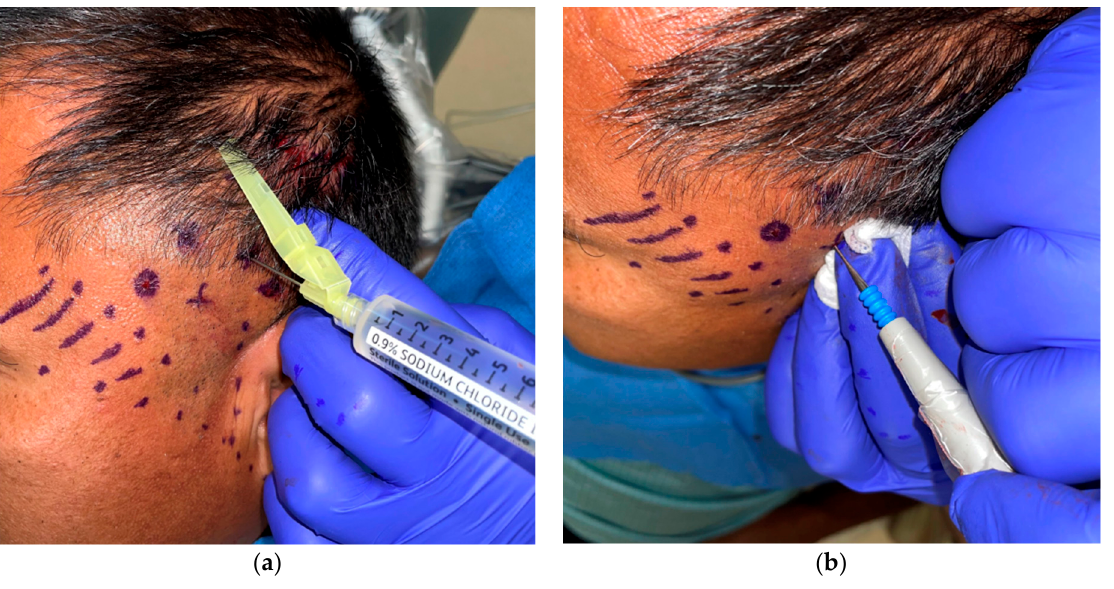
Figure 3. ( a ): 0.9% normal saline is injected into each trigger point using an 18 G needle. ( b ): Electrosurgery is performed on each trigger point for 5 s to a setting of 20 watts on coagulate.